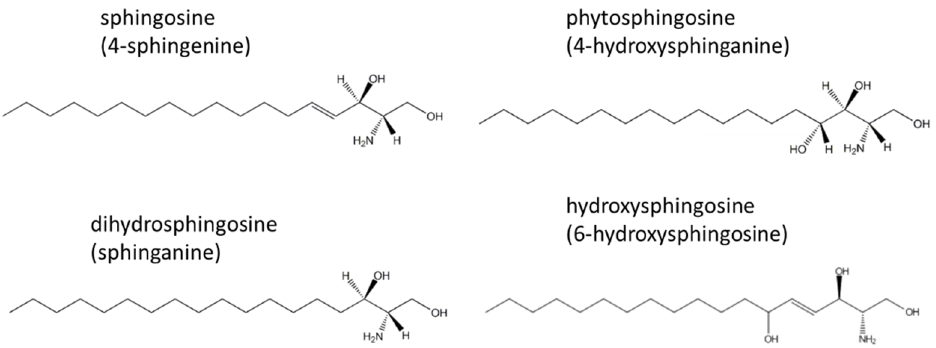
Figure 1. Four types of sphingoids are produced by the hydrolysis of ceramide by SCDase: sphingosine (4-sphingenine), dihydrosphingosine (sphinganine), phytosphingosine (4-hydroxysphinganine), and hydroxysphingosine (6-hydroxysphingosine).